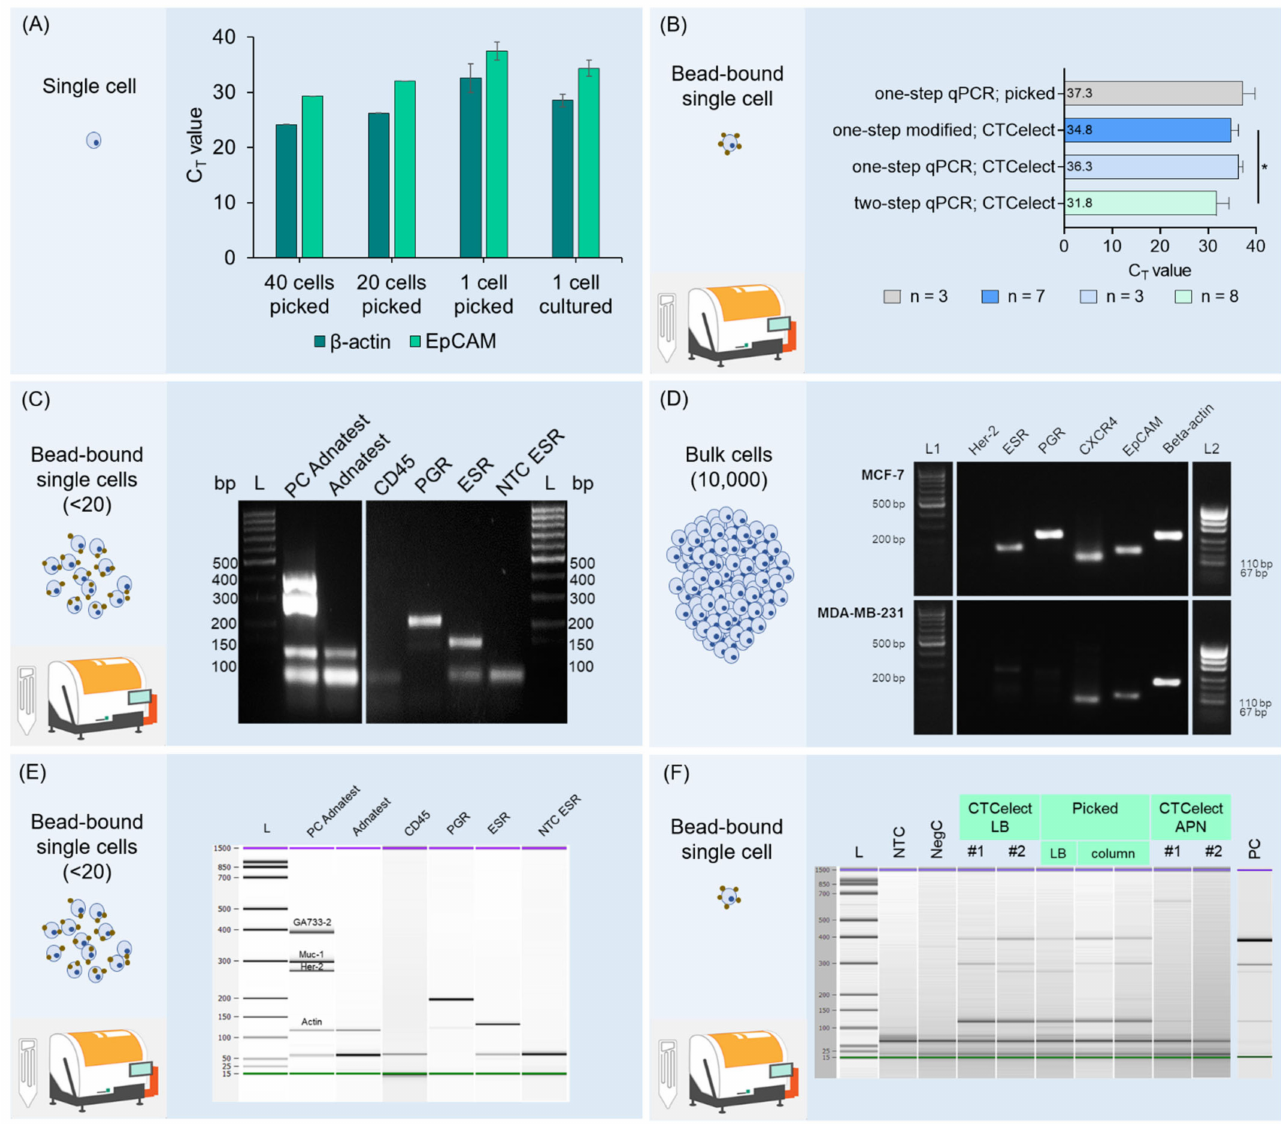
Figure 5. Establishment of simplified tumor marker-relevant PCRs from bead-bound single cells. ( A ) qPCR results after a two-step protocol using mRNA from 1, 20 and 40 MCF-7 cells with